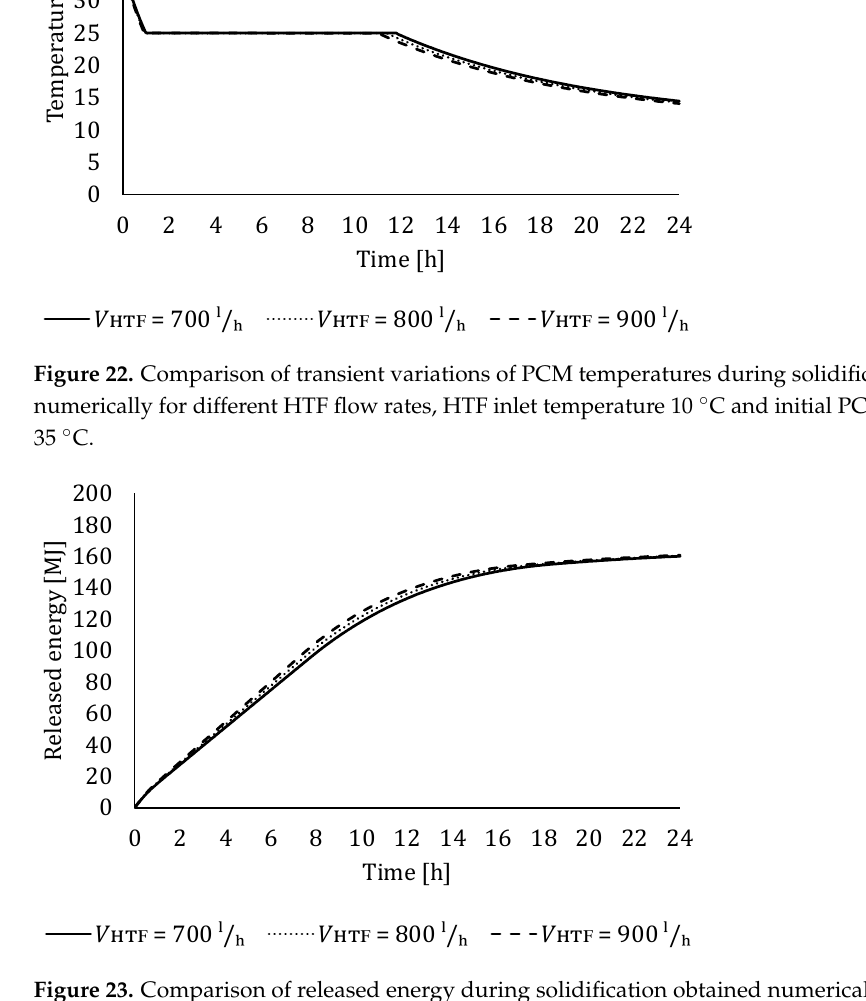
Figure 24. Comparison of mean heat transfer rate during solidification obtained numerically for different HTF flow rates, HTF inlet temperature 10 °C and initial PCM temperature 35 °C.